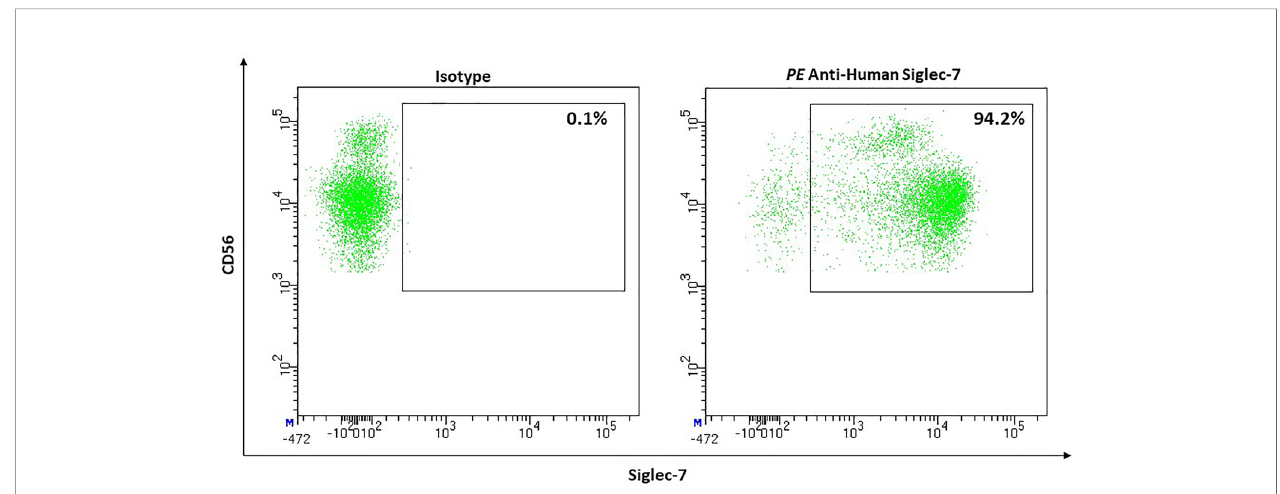
FIGURE 12 | Representative fl ow cytometric analysis of the expression of the immune checkpoint Siglec-7 on resting NK cells of a healthy donor (male, 23 years old) compared with isotype